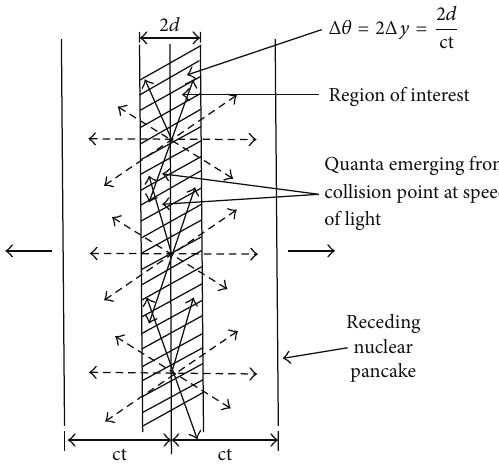
Figure 39: Geometry for the initial state of centrally produced plasma in nucleus-nucleus collisions. This picture is valid in any frame in which the incoming nuclei have very high energies and so, are Lorentz contracted. The figure is taken from